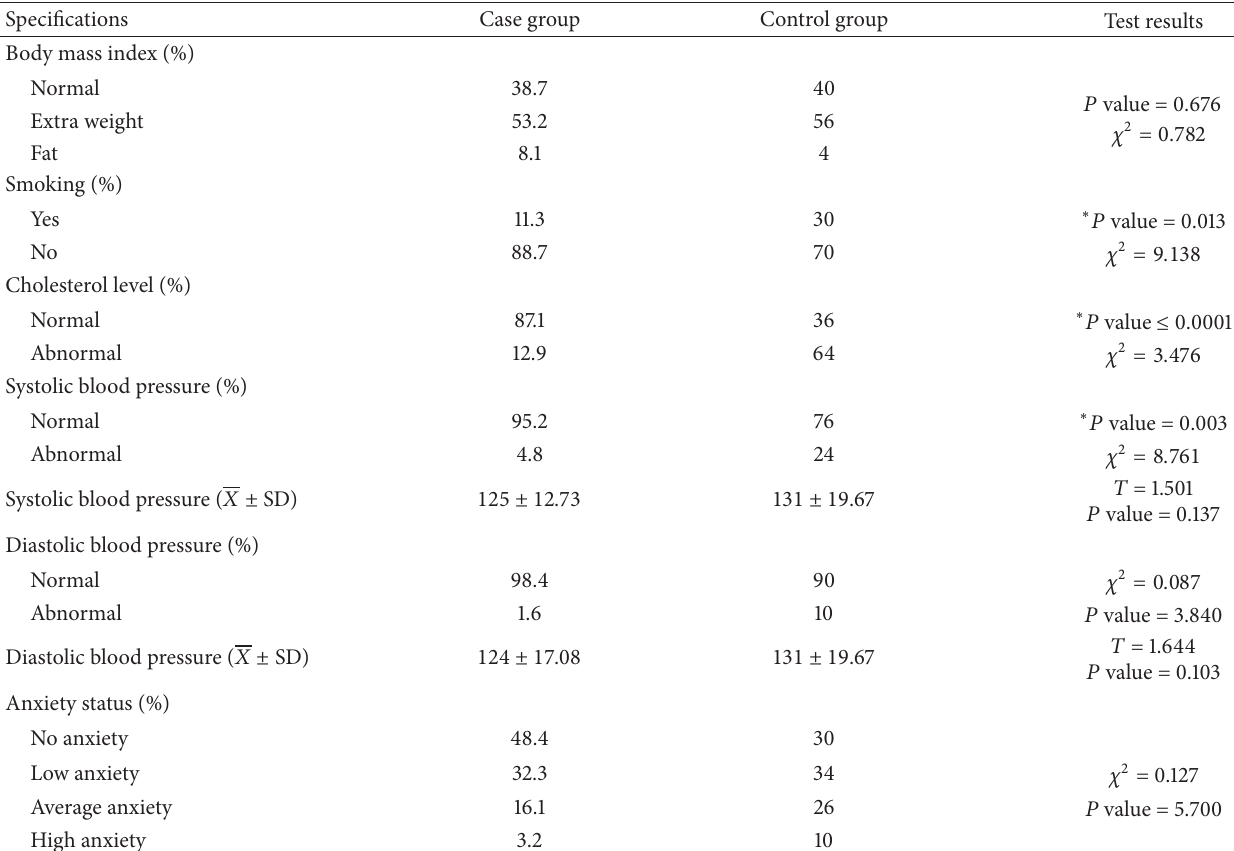
Table 2: Determination and comparison of level of anxiety, body mass index, cholesterol, blood pressure, and quitting smoking four months after education in the patients with myocardial infarction in the case and the control groups.